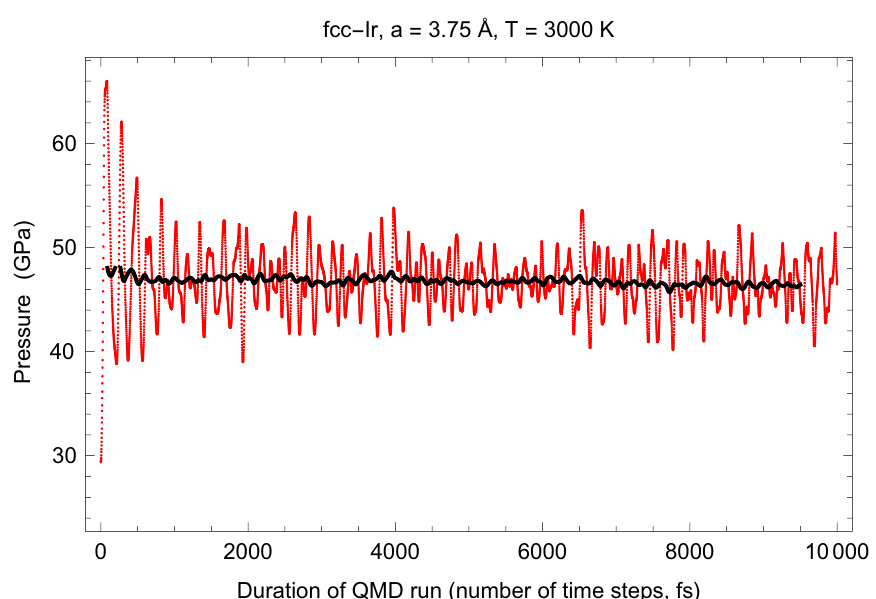
Figure 2. Time evolution of pressure during the 10,000 time step run of fcc-Ir with a lattice constant of 3.75 Å under a fixed temperature of 3000 K using the Nosé algorithm. The moving average is shown as a black line. In the vertical axis, pressure is in GPa.